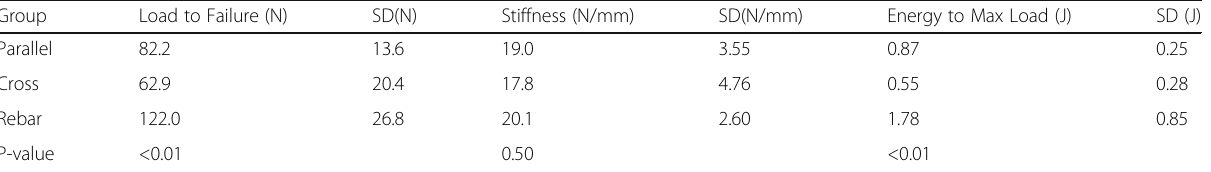
Table 4 Lateral Meniscus Biomechanical Data of 2 parallel stitches, Cross Stitch and Rebar Repair Group